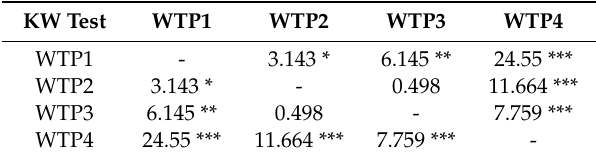
Table 3. KW tests for WTP across pictures (significant at *: 10%, **: 5%, ***: 1%). KW Test